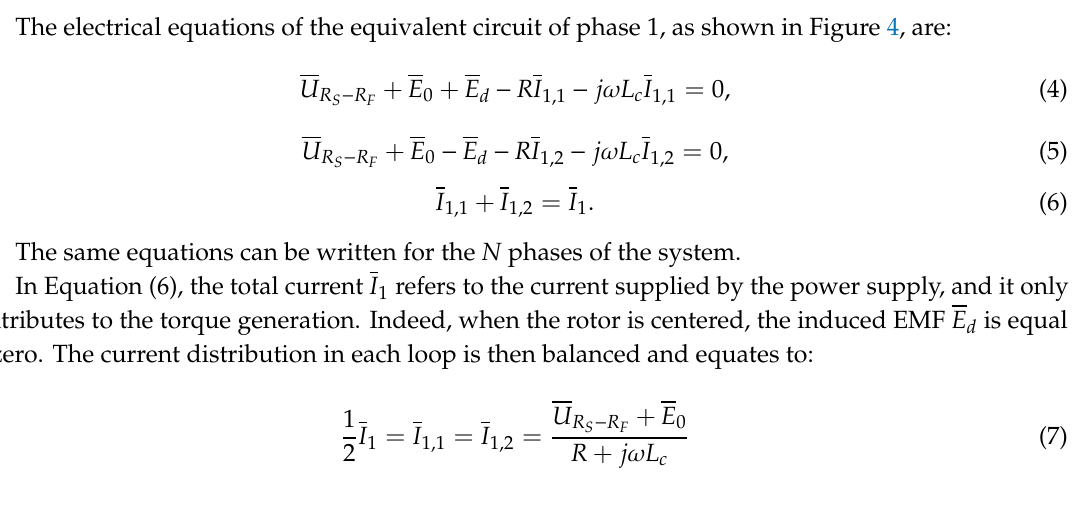
Figure 4. Equivalent electrical circuit of phase 1 of a multifunction winding for a one-pole pair internal inductor, with R the resistance of one coil, L c , the cyclic inductance of one coil, E 0 , the electromotive force (EMF) when the rotor is centered and E d , the EMF linked to the center shift.